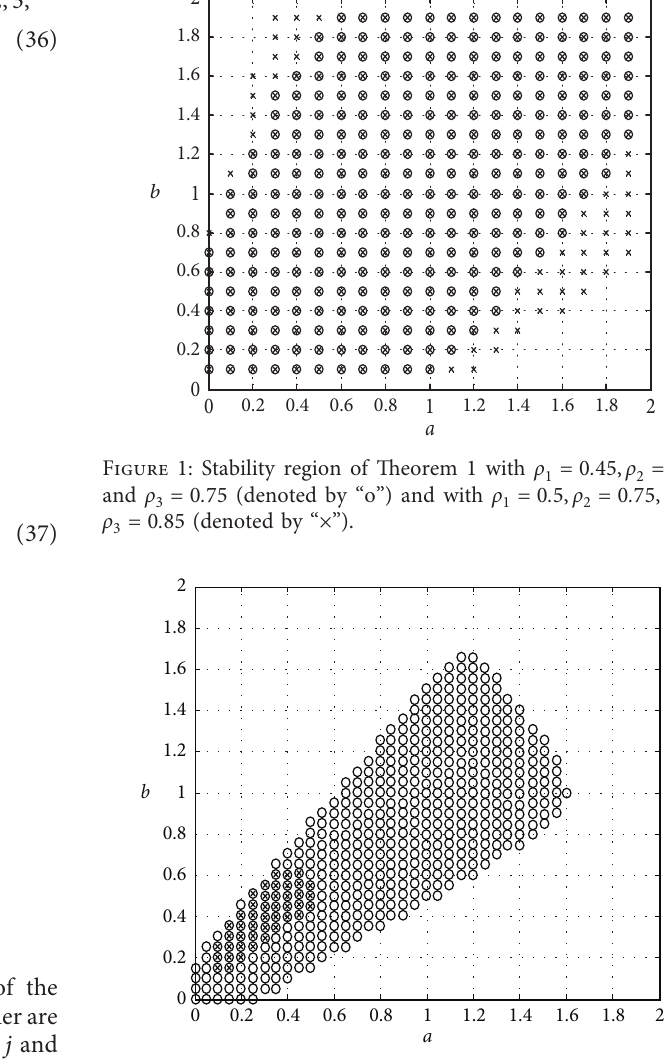
Figure 2: Stability conditions in [5] (denoted by “x”) and in [6] (denoted by